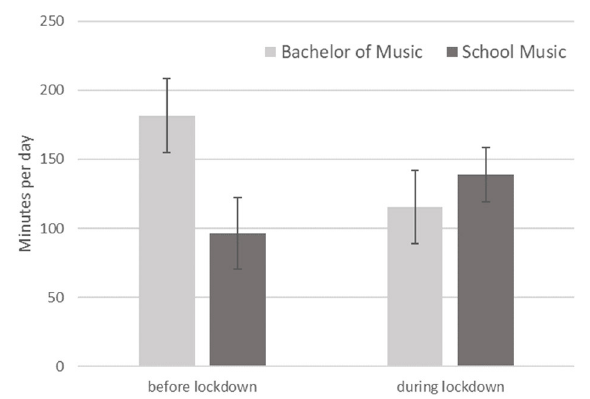
location and time, Wilcoxon tests have been performed. Effect sizes were reported by using Cohen’s d (Cohen, 1988). The level of statistical significance was set to